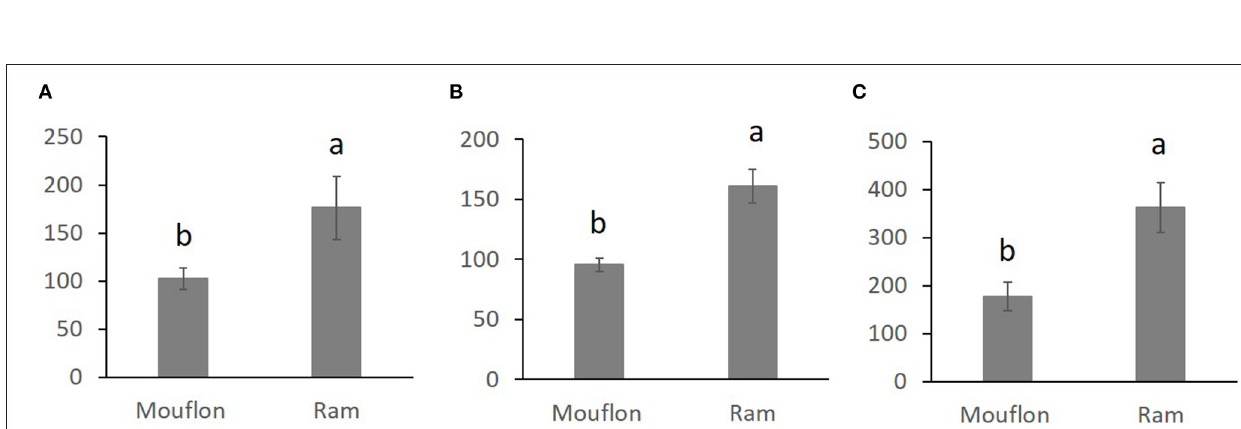
FIGURE 1 | Stress resistance factor (SR) (mean ± SE) for integrity of mitochondrial membrane after 20h of refrigeration at 15 ◦ C (A) and after 20h of refrigeration at 15 ◦ C and subsequent incubation at 38 ◦ C for 2h (B) in wild and domestic boar sperm samples. Means within different letters are significantly different ( p < 0.05) between species.